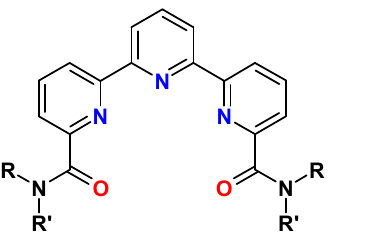
Figure 5. 6,6″(2,2’:6′,2″-tripyridine)-dicarboxylic acid diamides ( TPyDA ). The solutions of TPyDA in nitrobenzene has high extraction ability to Pu(IV), Np(V, VI), U(VI) [121,122]. However, they extract both lanthanides and americium very weakly. The SF Am/Eu is only 5, despite the presence of three “soft” reaction centers. Metal distribution ratios decrease with increasing nitric acid concentrations in the aqueous phase due to the high basicity of the ligand (рКа = 1.0), resulting in easy protonation [123]. 7. Diamides of 1,10-Phenanthroline-2,9-dicarboxylic Acid (PHENDA)